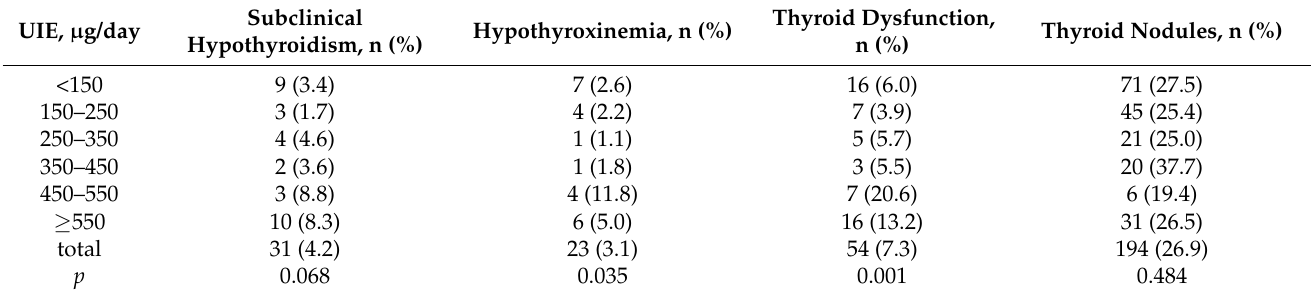
Table 3. Thyroid dysfunction and thyroid nodules in pregnant women in terms of UIE (N = 744).